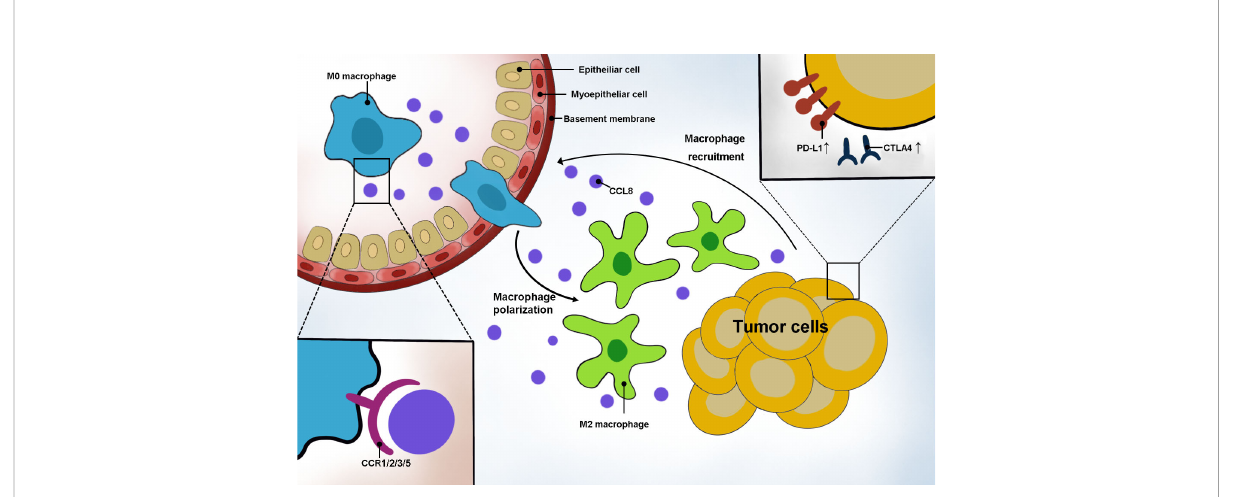
FIGURE 8 Schematic representation of CCL8 ’ s role in DLBCL. Tumor cells secreted CCL8 to recruit macrophage moving around the tumor by binding with the CCR family and promoting macrophage polarization to the M2 type. In addition, highly CCL8-secreting tumor cells had an elevated expression of PD-L1 and